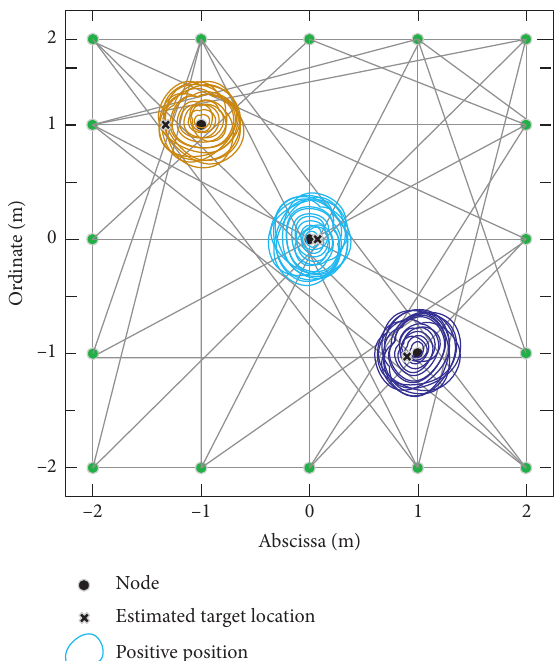
Figure 9: Comparison of horizontal and vertical directions of real track and tracking track.